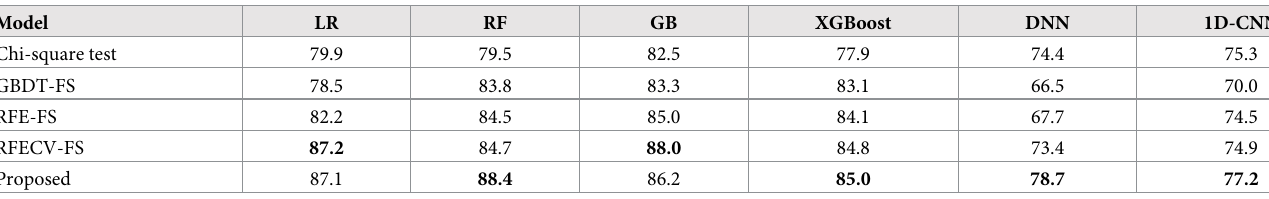
Table 7. AUC comparison results for different feature selection